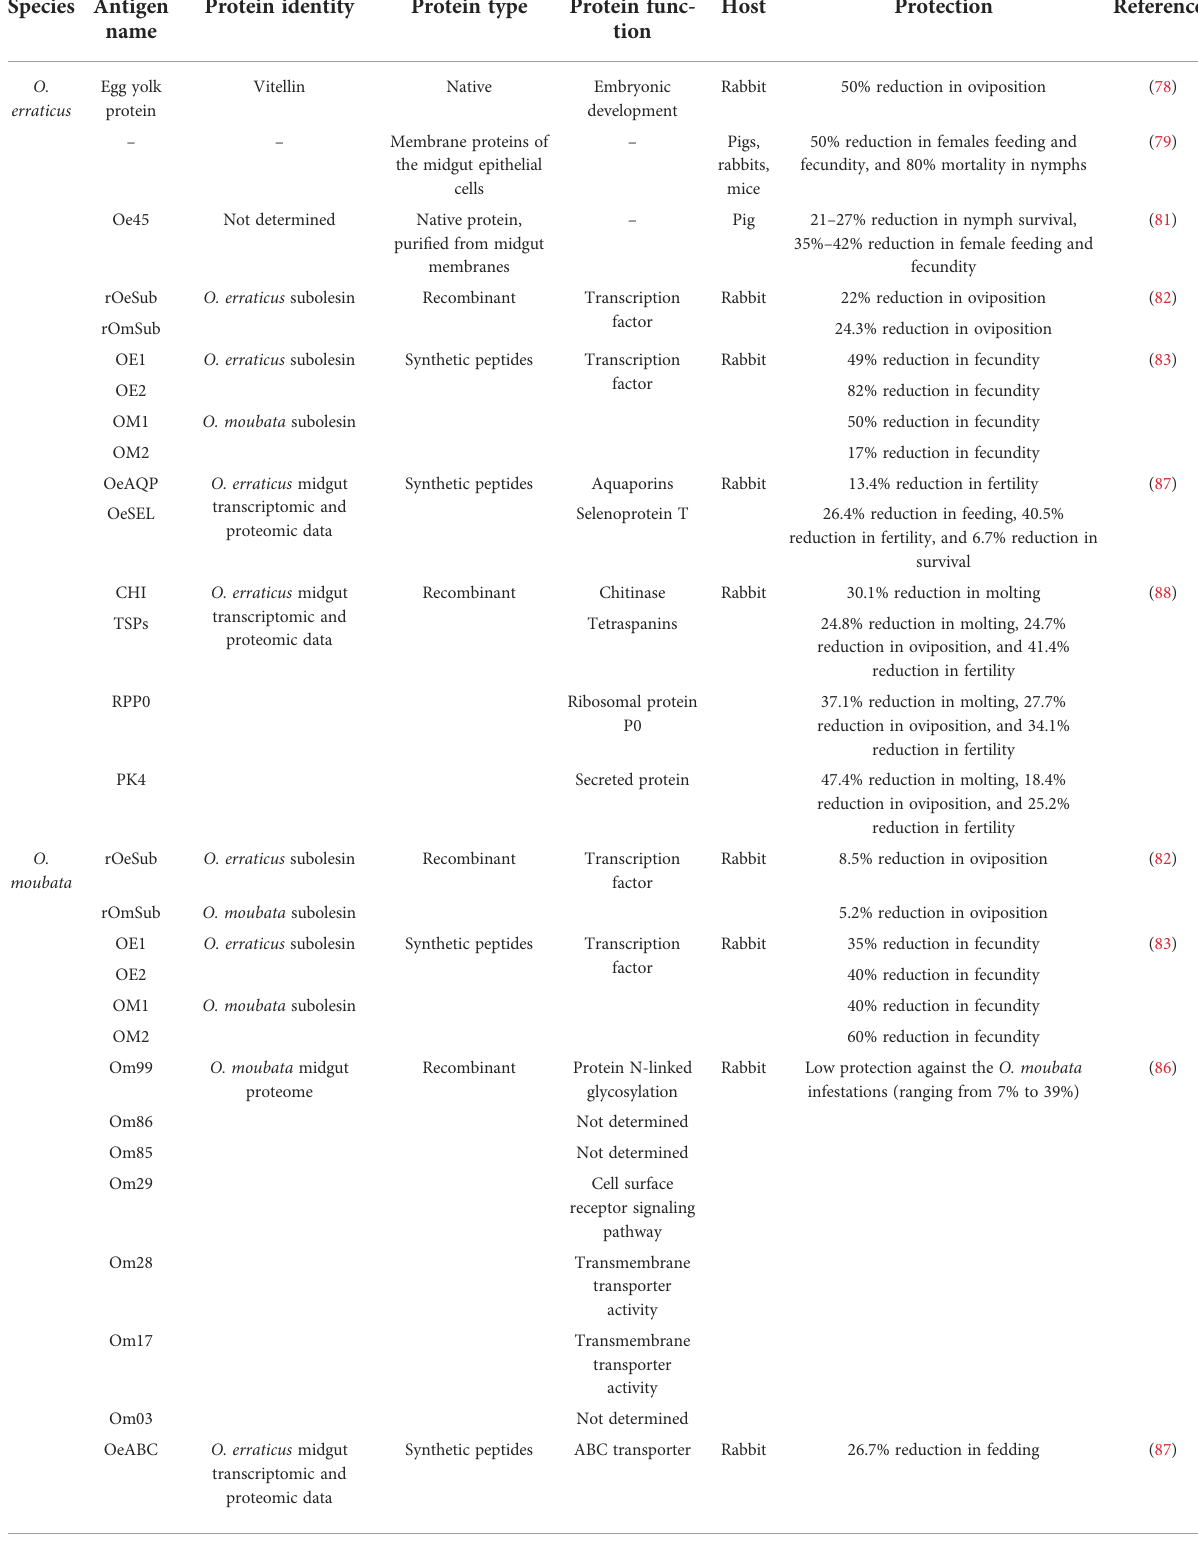
TABLE 2 Effective vaccines using concealed antigens from Ornithodoros